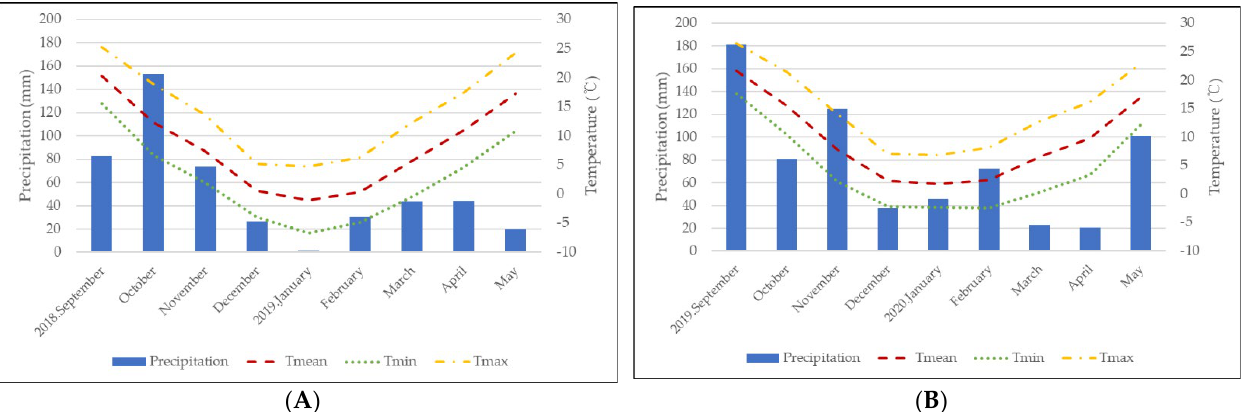
Figure 1. Total amount of precipitation, monthly mean air temperature (Tmean), minimum (Tmin) and maximum (Tmax) air temperature recorded during the two-year growth period. ( A ) 2018–2019, ( B ) 2019–2020.